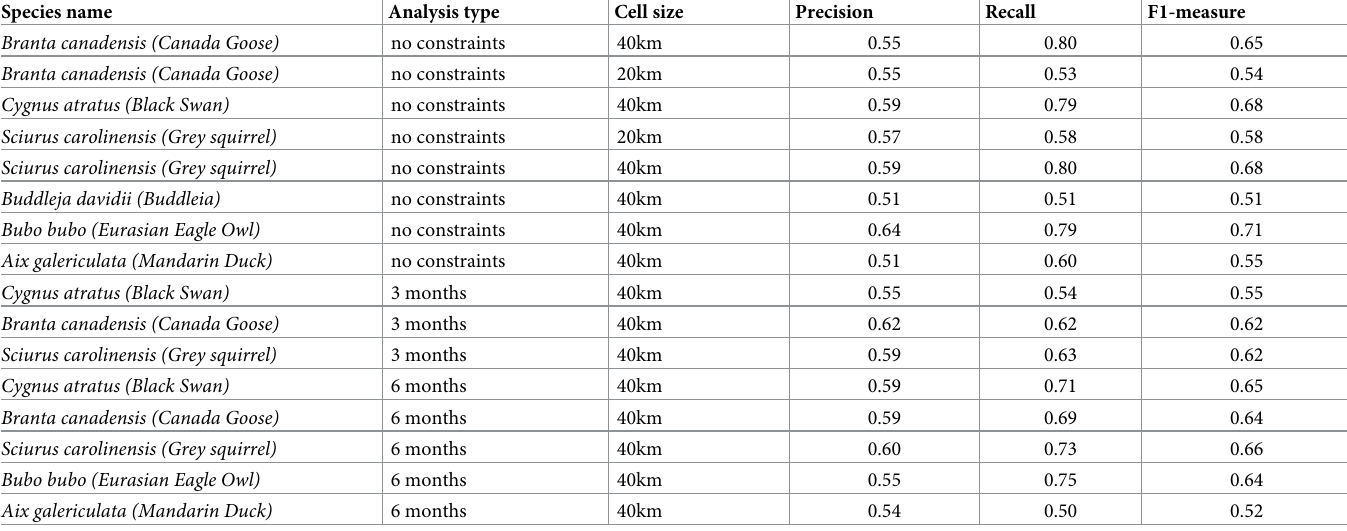
Table 7. Results for the invasive species where precision and recall are both above